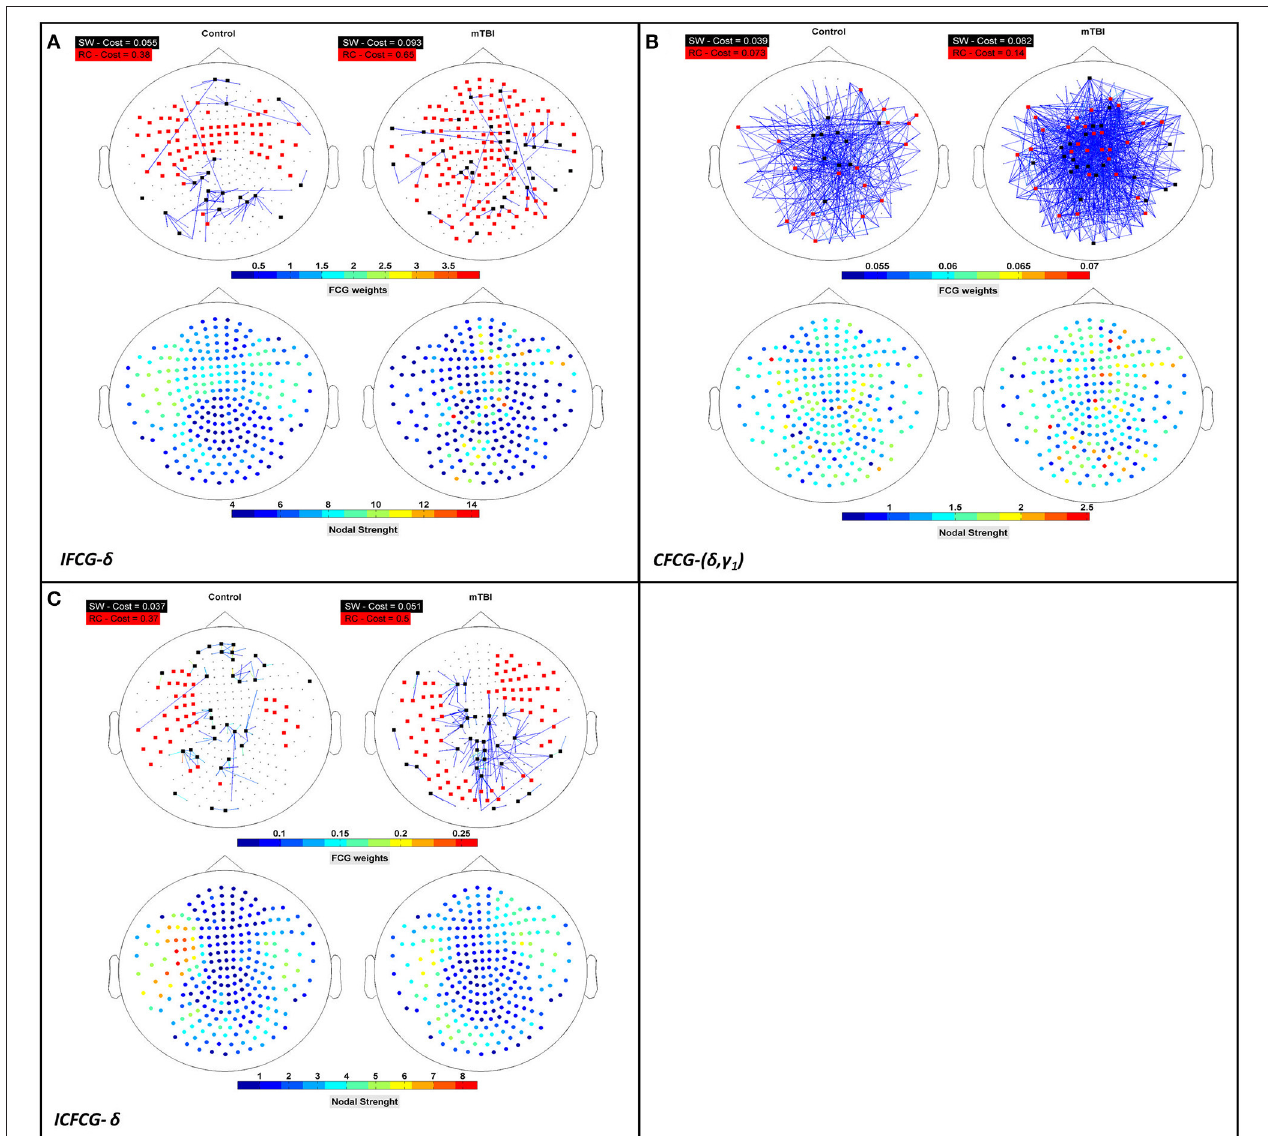
FIGURE 5 | Representation of the SW network (colored edged + black-washed SW nodes on top topographies for each sub-image) simultaneously with the RC topology (red nodes on top topographies for each sub-image) and the corresponding nodal strengths (colored bottom topographies for each sub-image) for each FCG type (A) IFCG (B) CFCG, and (C) ICFCG in specific frequency bands and frequency pairs. Each color bar is common to the control and mTBI